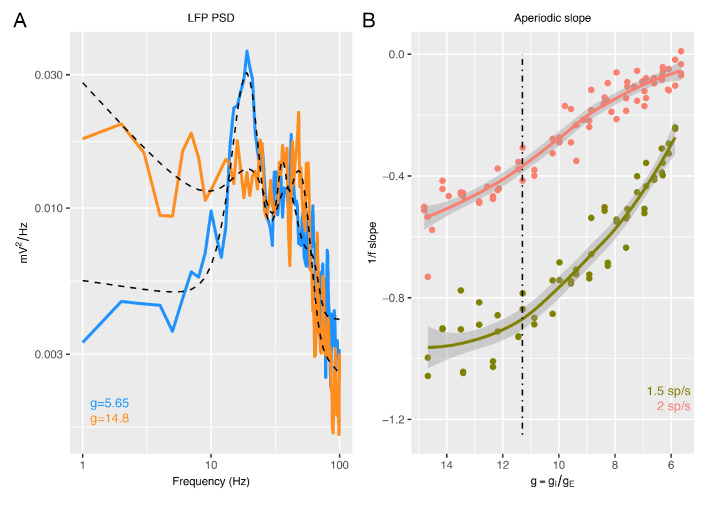
1/f slope estimation with the FOOOF algorithm.Panel A provides two examples of the LFP PSD generated from the recurrent model for different values of the E:I ratio or g (blue, g = 5.65; orange, g = 14.8). Plotted over the PSDs are the FOOOF algorithm (Haller, 2018) model fit (dotted lines), which captures both the aperiodic signal along with the periodic oscillatory signals. Panel B shows how 1/f slope computed from FOOOF changes as a function of g for two different types of thalamic input.